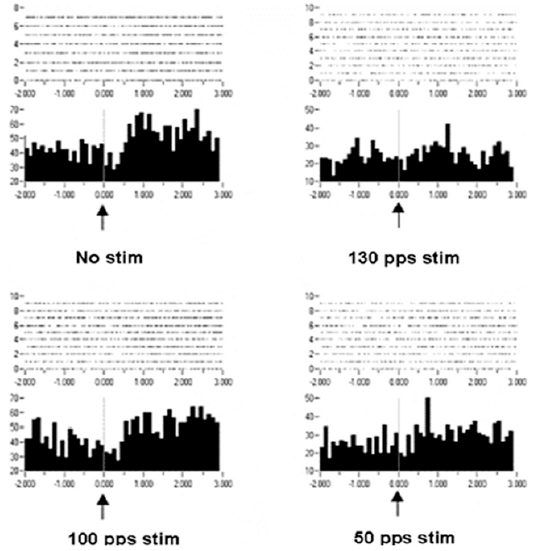
Figure 9. Peri-event rasters and histogram showing activity of a caudate nucleus neuron before and after onset of the commencement signal, indicated by the up arrow. Each dot in the rasters represents a neuronal discharge and each row represents a trial. Summing a column in the raster produces the histogram. With no stimulation, with 100 pps DBS, and, to a lesser degree, with 50 pps DBS, there is an increase in neuronal discharge following the onset of the commencement signal. This dynamic modulation is lost with the 130-pps DBS [25].